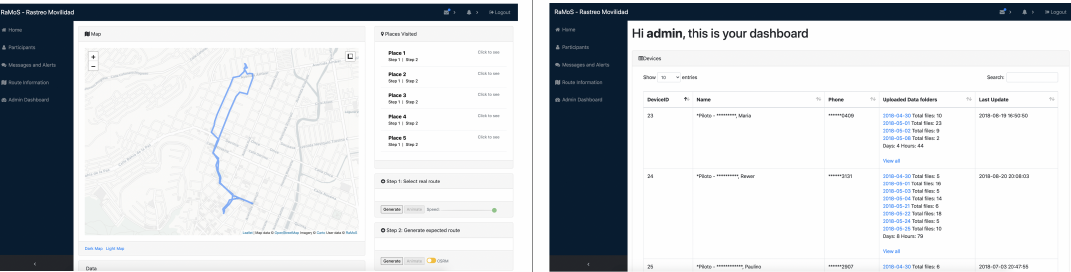
Figure 3. Administrator tools on the server side include a dashboard to manage devices, campaigns, and users, as well as data visualization and analysis